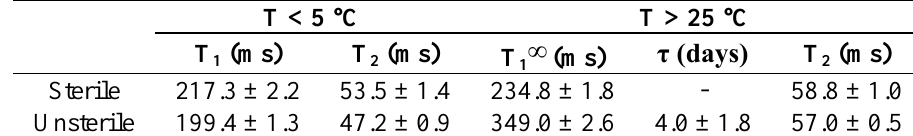
Table 1. NMR Relaxation Parameters for Tomato Samples.